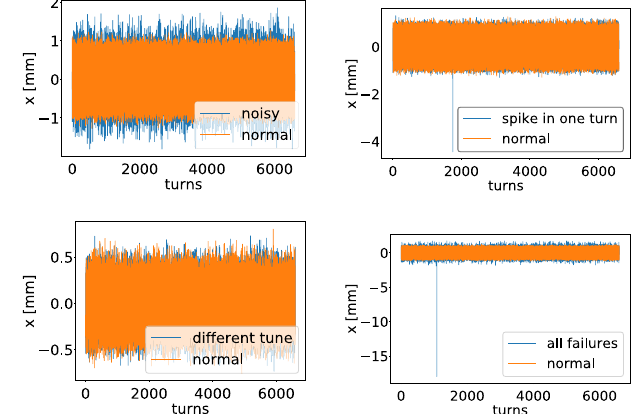
FIG. 5. Simulated turn-by-turn data of the bad BPMs compared to normal unperturbed signal over 6600